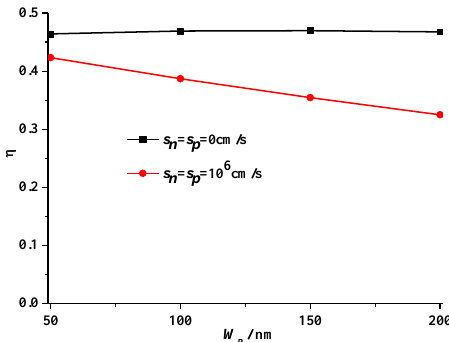
Figure 6. Conversion efficiency of the battery with different W P.